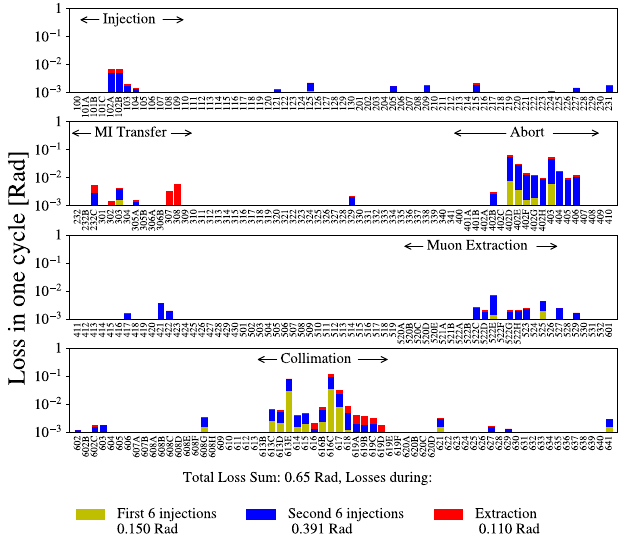
FIG. 9. Typical loss pattern after the implementation of the diode damper which allowed chromaticity to be dropped at the end of the cycle. Intensity is around 45 × 10 12 ppp.